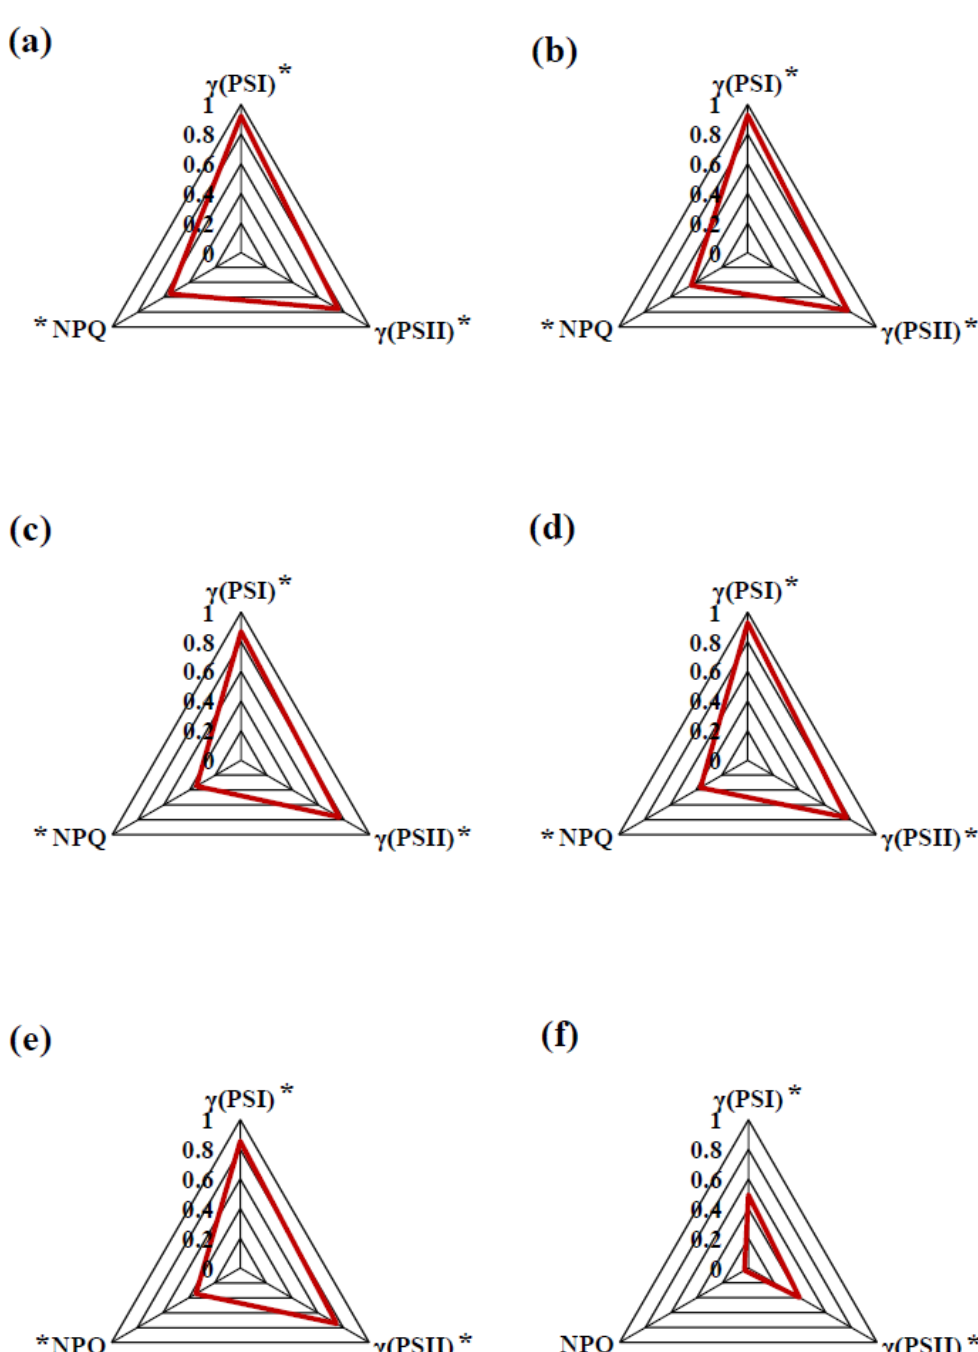
Figure 7. Determination coefficients (R 2 ) for the linear regressions, which were calculated on the basis of dark averaged experimental values (only time points measured without actinic light) of the photosynthetic parameters and ∆ PRI(515,570) (a) , ∆ PRI(525,570) (b) , ∆ PRI(531,570) (c) , ∆ PRI(535,570) (d) , ∆ PRI(545,570) (e) , and ∆ PRI(555,570) (f) . The coefficients were calculated on the basis of the results from Figures 2 and 3; the details of the relations are shown in Figures S13–S18 (Supplementary Materials). * indicates that the relation was significant ( p < 0.05 for the correlation coefficients between these values).